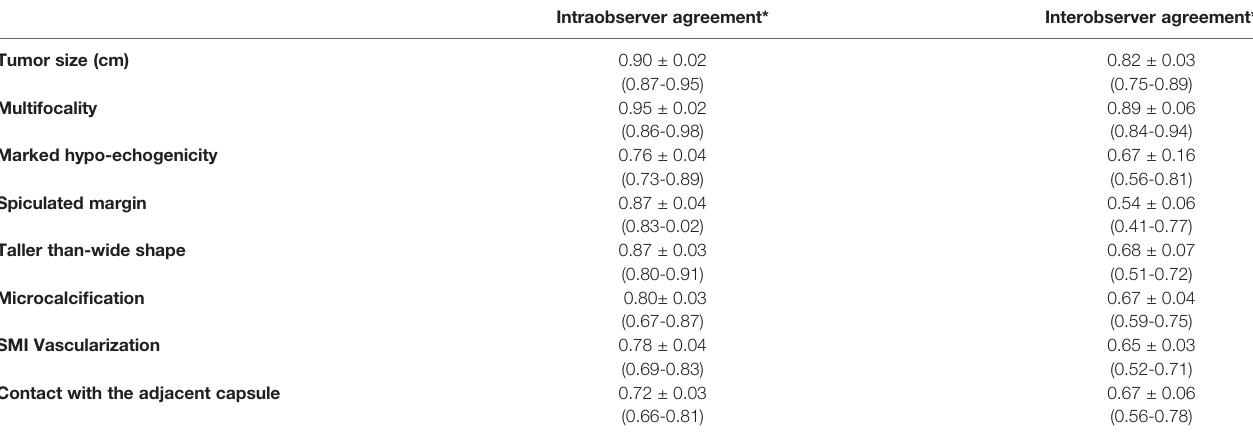
TABLE 1 | Intraobserver and interobserver agreement on the ultrasonographic